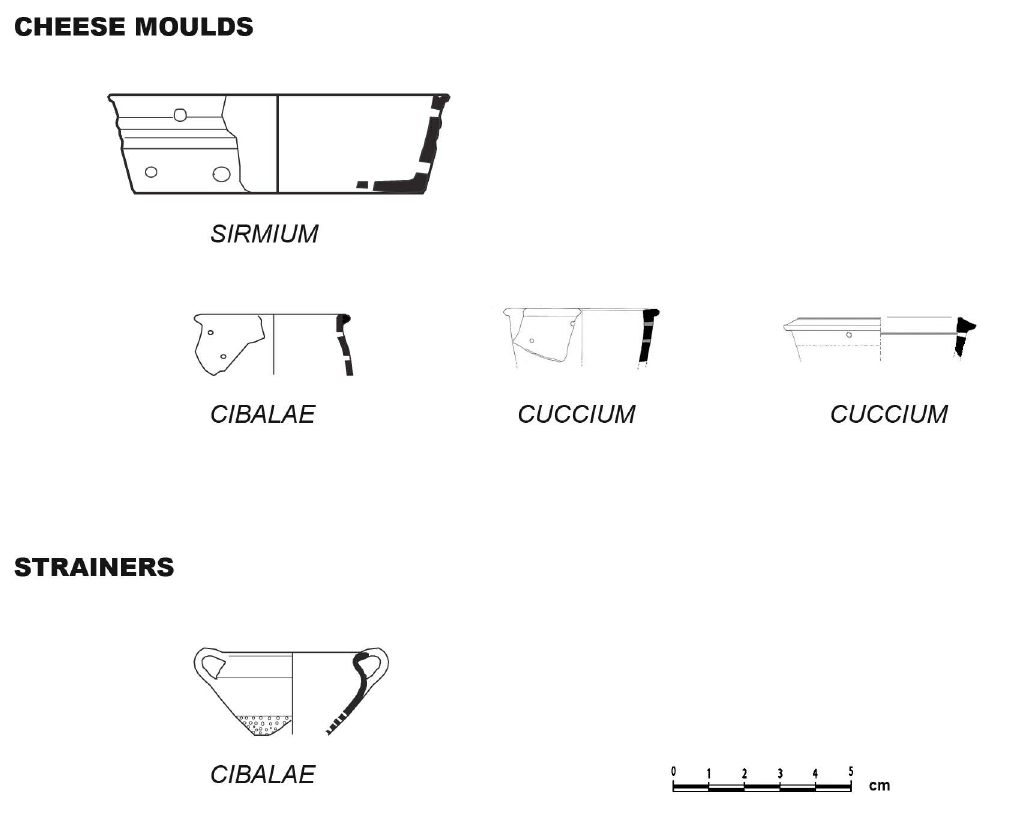
Figure 7: Examples of cheese moulds and strainers from southern